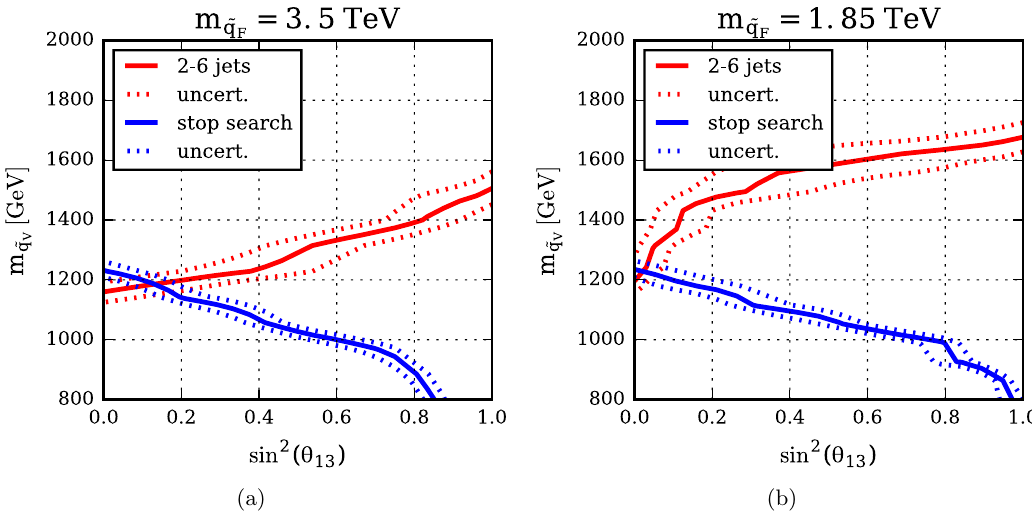
Figure 4 . Mass limits on squarks in case of flavour mixing between 1st and 3rd generation (as- suming left-right universality). For details on the definition of q